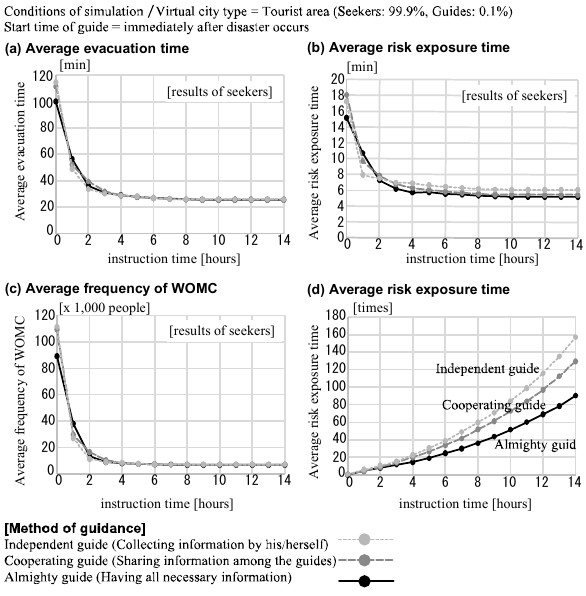
Figure 14. Influence of variations in method of guidance We herein assumed that misinformation (the passing on of information that is actually false) occurs a certain percentage of the time in regard to disaster information in WOMC among evacuees. Specifically, in order to visualize the process of misinformation, the numbers of people providing information shown in Figure 6 were inter-changed (Figure 15). As before, the information provided in WOMC by guides was assumed to be 100% accurate. Below, in addition to the evaluation indicators for evacuation time and risk exposure time, the Figure 13. Spatial distribution of the location information of fraction of misinformed evacuees, an indicator of the degree of evacuation area dissemination of false information, is examined.